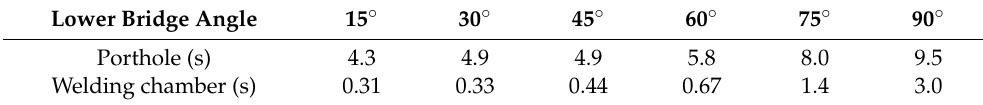
Table 2. The time needed for the seam material to pass through the porthole and welding stage.